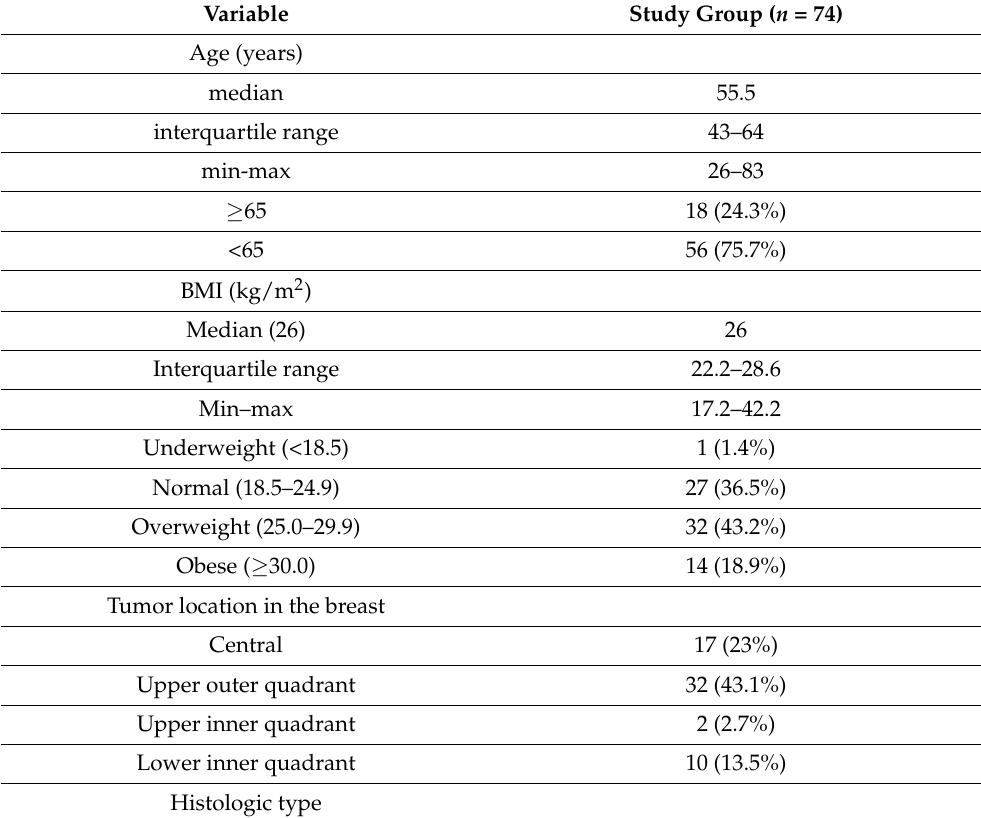
Table 1. Demographic and clinical characteristics of the